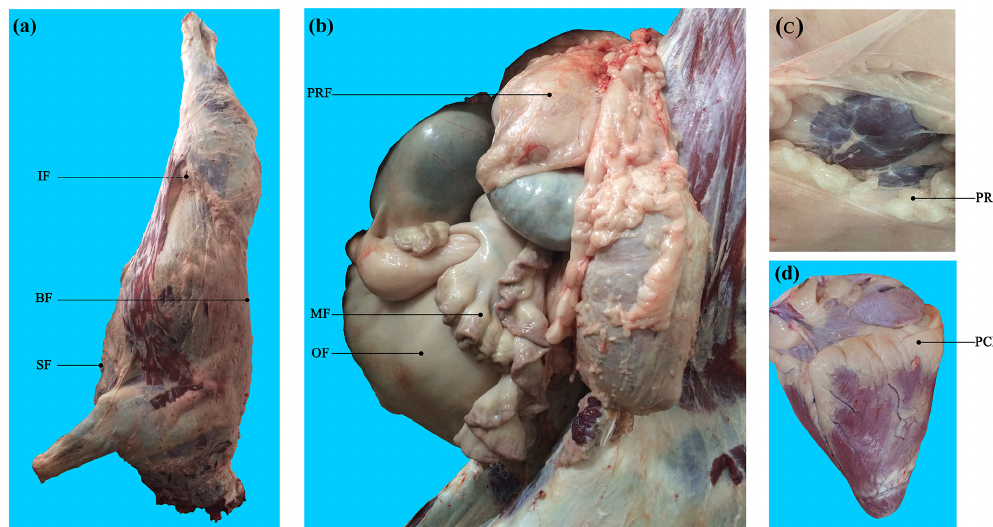
Figure 1. Visualization of adipose tissue depots sampled in buffalo. (a) Carcass of a Binlangjiang buffalo. (b) The abdomen was opened up to expose the internal organs. (c) The perirenal fat was peeled off to expose the kidney. (d) The heart. A total of seven depots were sampled. BF, back fat; SF, sternum fat; IF, inguinal fat; PRF, perirenal fat; MF, mesenteric fat; PCF, pericardial fat; OF, omental fat. The same abbreviations are used in Figs. 2 and